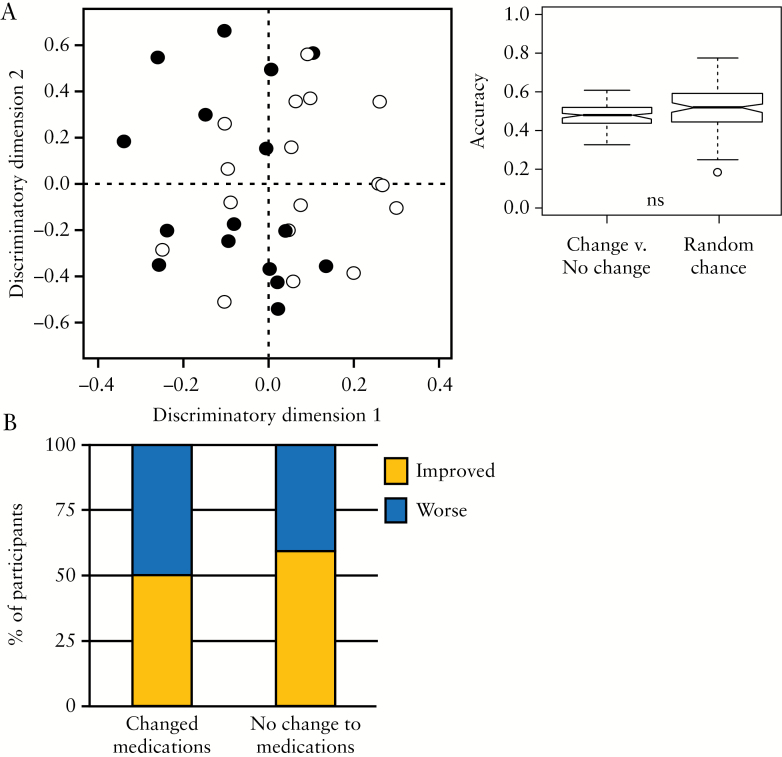
[A] OPLS-DA scores plot is unable to discriminate between the metabolite profiles of patients who changed medication [white] during the course of the study compared to those with no change in medication [black]. [B] Box plot of the percentage of patients who improved/worsened following a change in medication compared to those who stayed on the same medications over the course of the study.